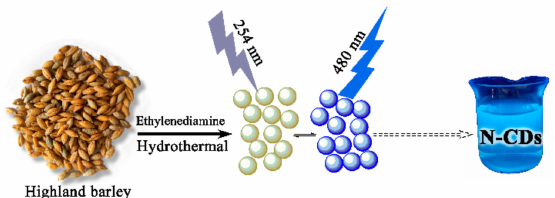
Figure 1. The preparation process of the N-CDs by hydrothermal method from Highland